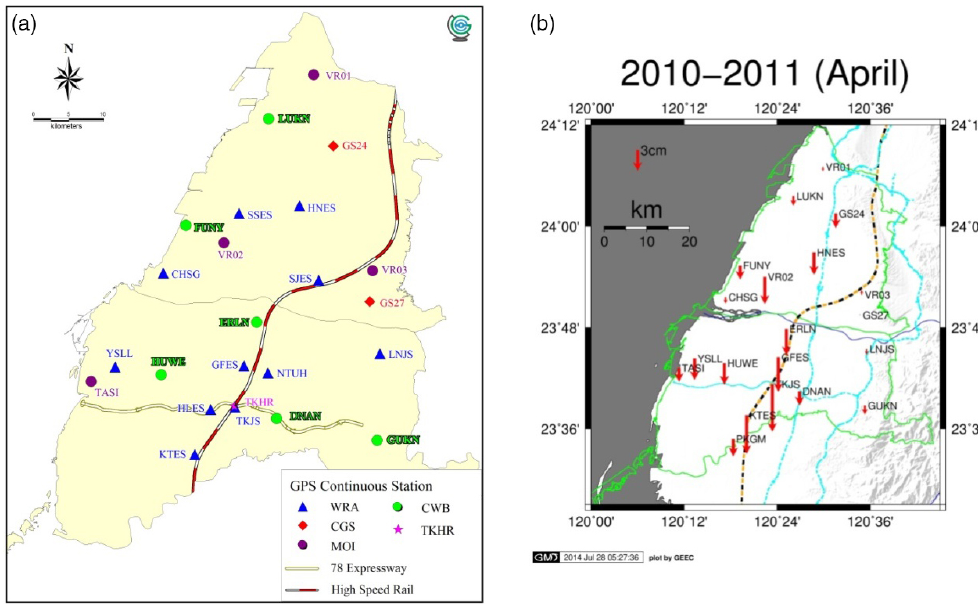
Figure 6. (a) Distributions of continuous GPS stations in CRAF (b) Vertical displacement rate from GPS over April 2010–April